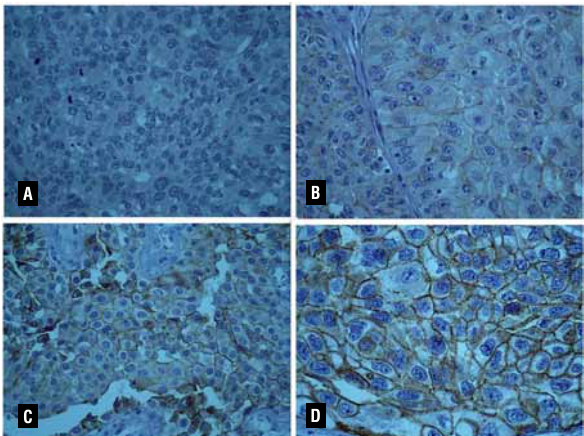
Figure 1 - Examples of the subjective analysis of the intensity of immune expression that was considered as negative (A), weak (B), moderate (c) and strong